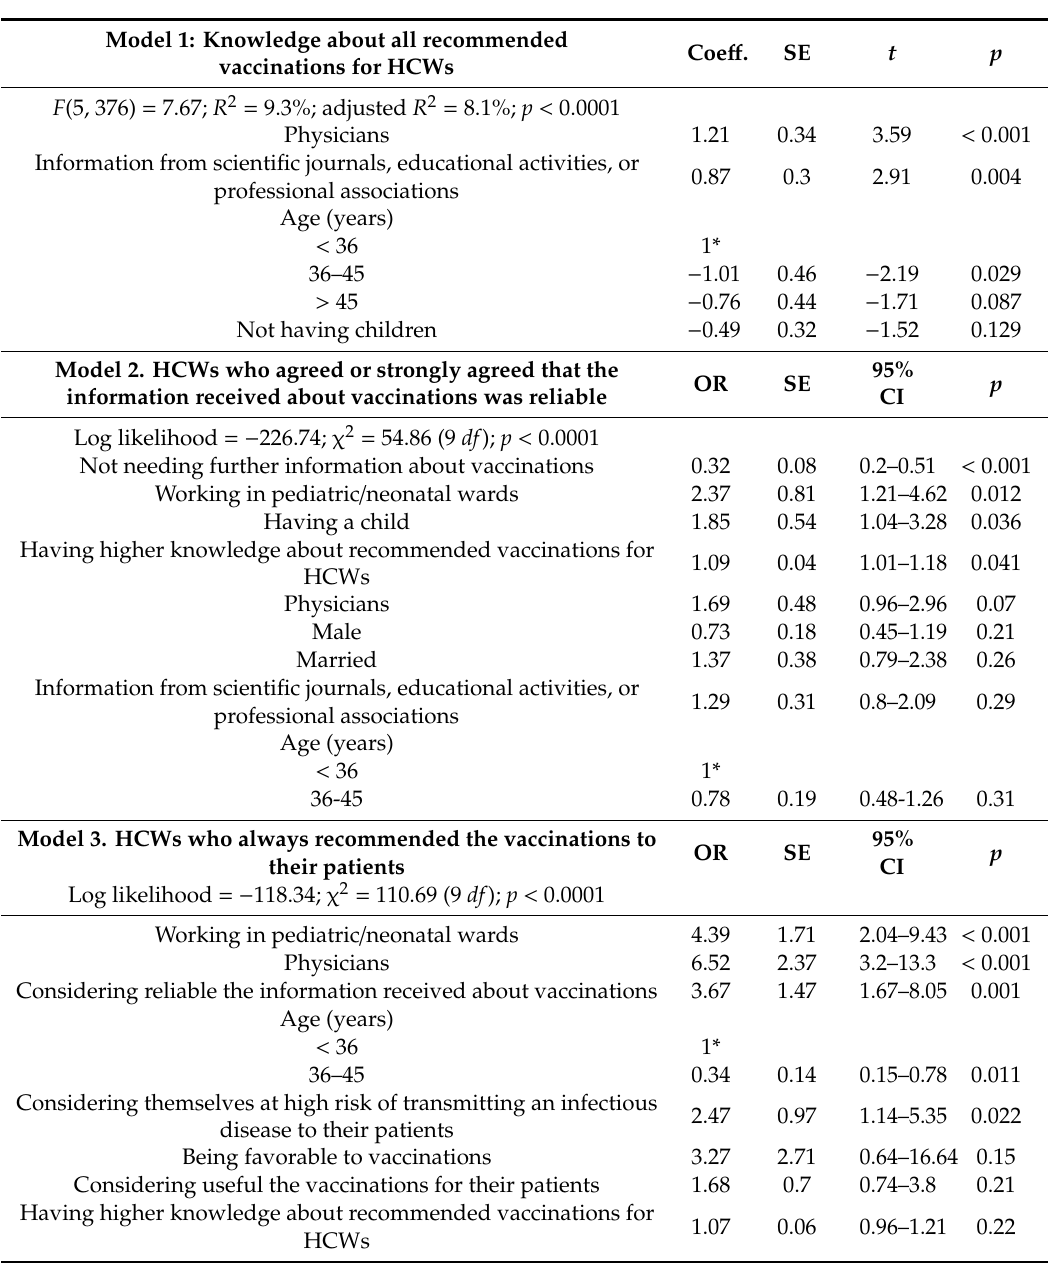
Table 2. Multivariate linear and logistic regression analyses to characterize factors associated with the di ff erent outcomes of